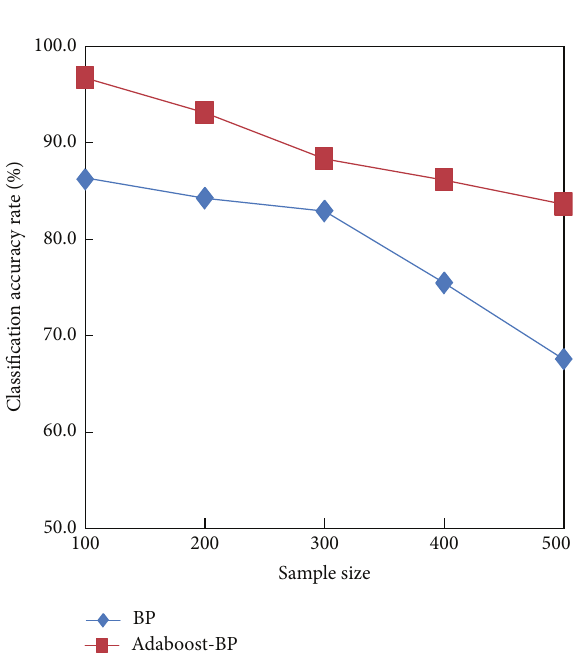
Figure 7: Comparison of the average classification accuracy rates of the BP neural network model and the Adaboost-BP neural network